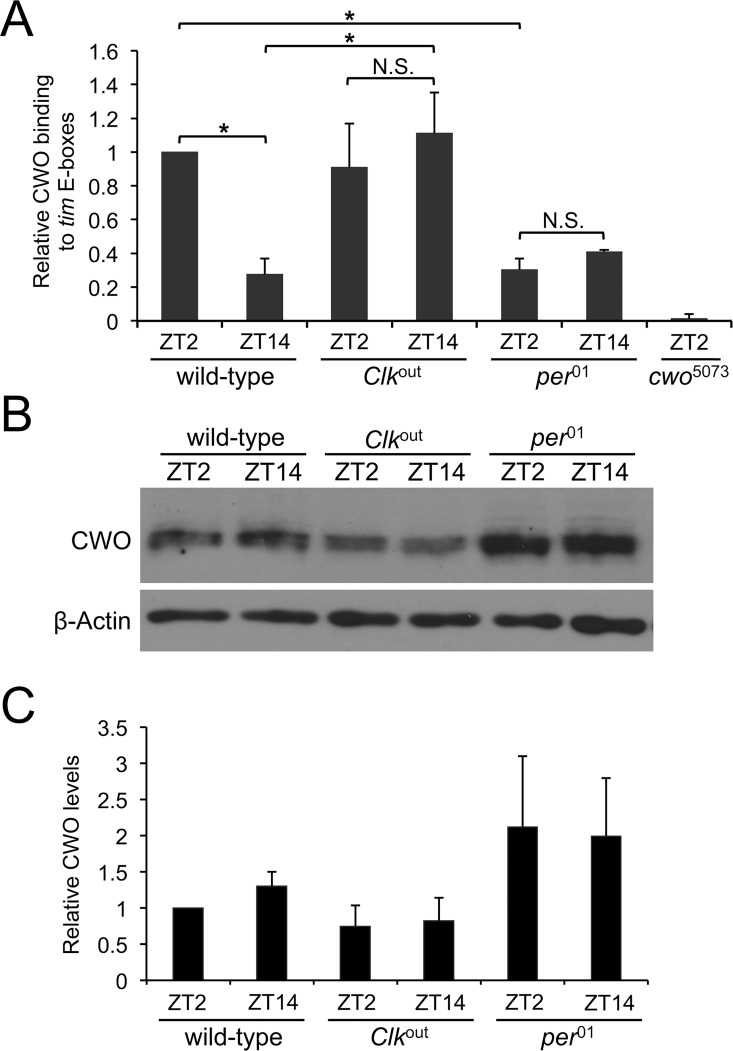
PER is required for CWO to compete with CLK-CYC for E-box binding.(A) ChIP assays were performed on wild-type, Clkout and per01 flies collected at ZT2 and ZT14, and cwo5073 flies collected at ZT2, as described in Fig 2A. The relative level of CWO binding to tim E-box-containing fragments was determined as described in Fig 2A. The signal from each sample was normalized to the wild-type ZT2 value of 1.0, then the means of each data set (n = 3) were calculated and plotted. Error bars represent the SEM (n = 3, *significantly different, ANOVA followed by Student-Newman-Keuls post-hoc test). (B) Western blot of head extracts from the same genotypes shown in panel A were probed with CWO antiserum. (C) Quantification of CWO levels in the blot from panel B and two additional Western blots containing samples from independent collections. Error bars indicate the SD.